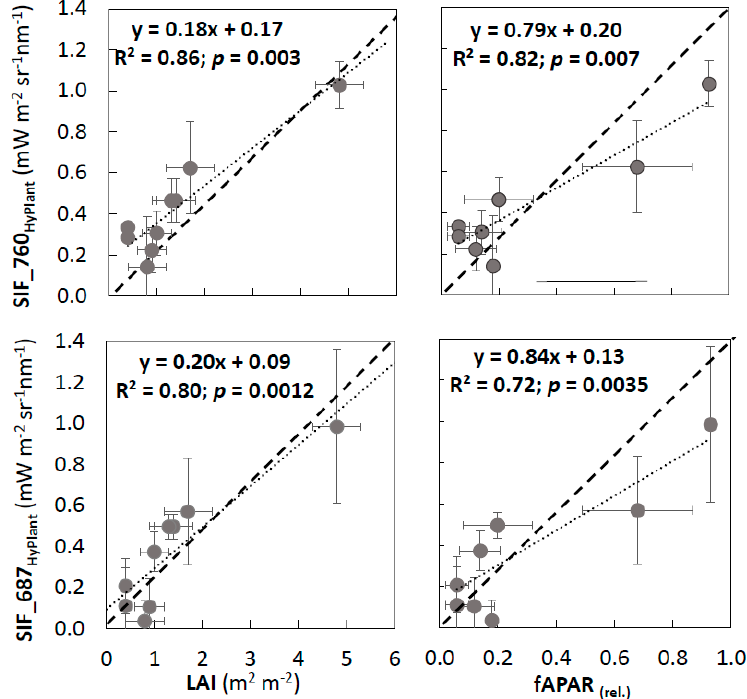
Figure 6. Relationship between HyPlant-derived SIF and LAI and fAPAR at the ground validation plots. Note: HyPlant SIF values were retrieved from the rescaled data (for details see Section 2.3.1).